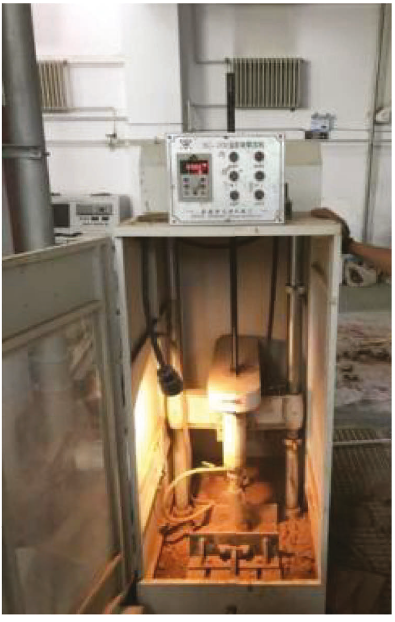
Figure 3: Automatic coring machine sampling.